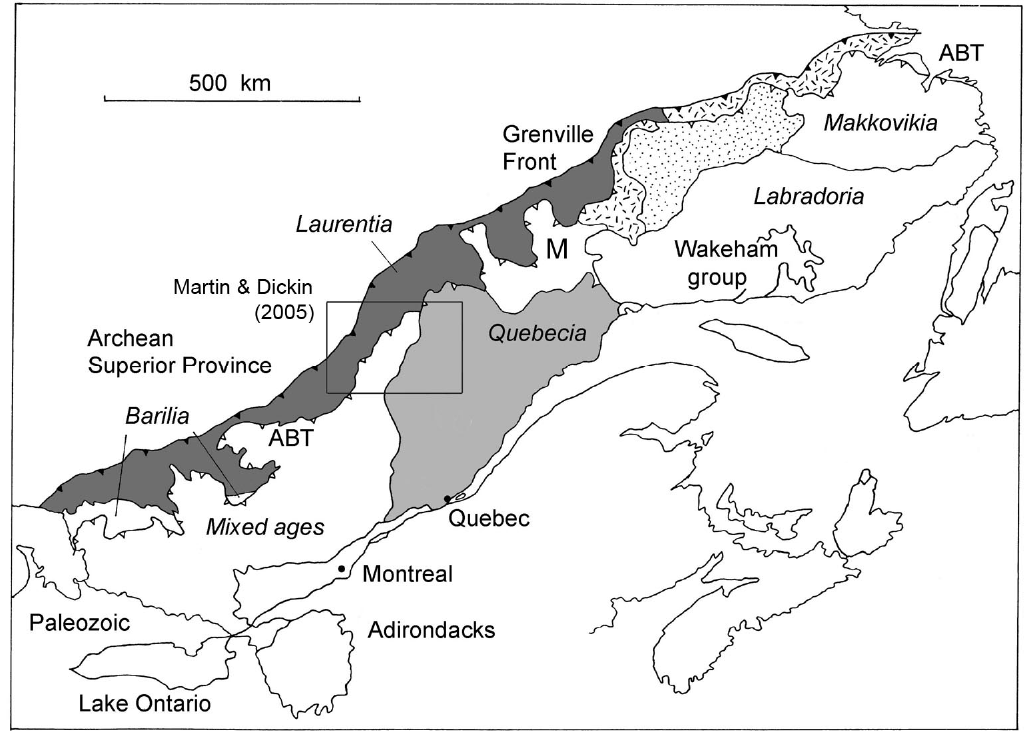
formation ages, after Dickin [3]. Boxed area = study of Martin and Dickin [4]; ABT = Allochthon Boundary Thrust [5]; M = Manicouagan meteorite impact site (Palaeoproterozoic